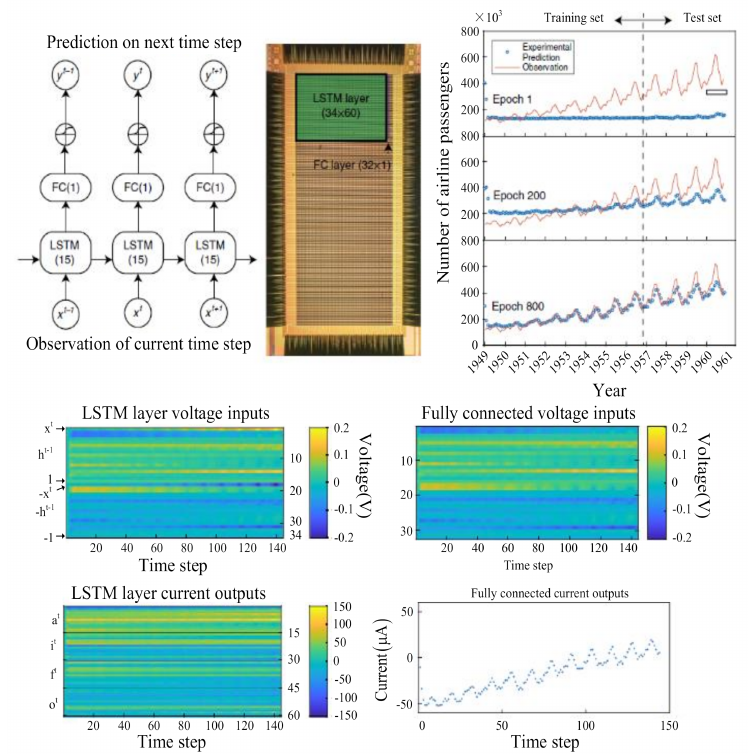
Figure 20. LSTM network based on memristor synaptic